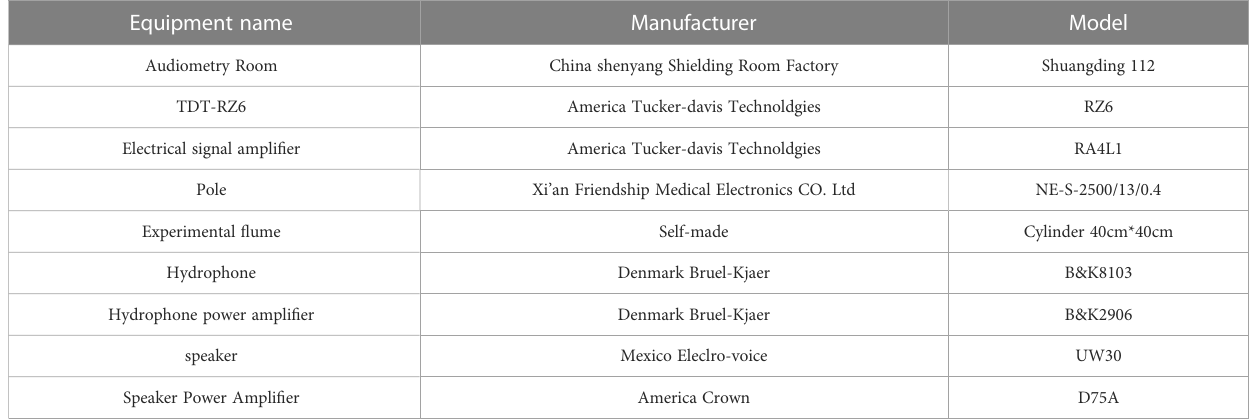
TABLE 2 Main experimental